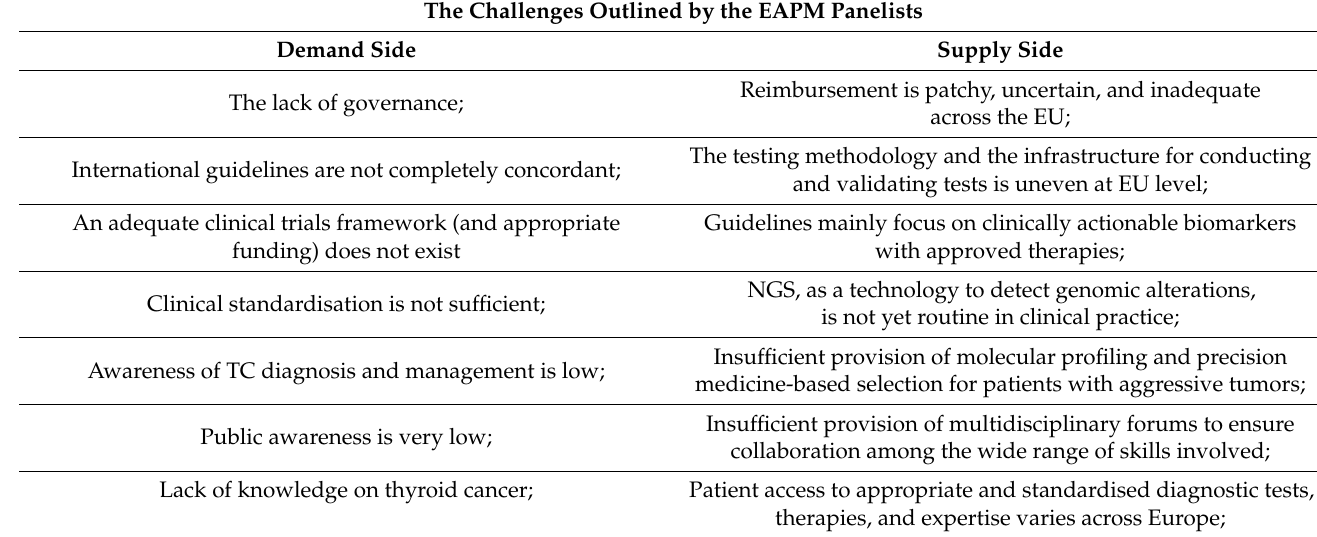
Table 1. Challenges regarding tackling thyroid cancer, categorised as demand side and supply side issues. The methodology used to form a consensus during the EAPM